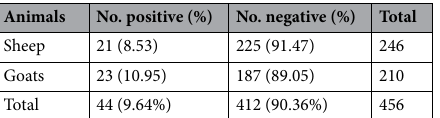
Table 1. Comparison of L. interrogans infection in sheep and goats with MAT.